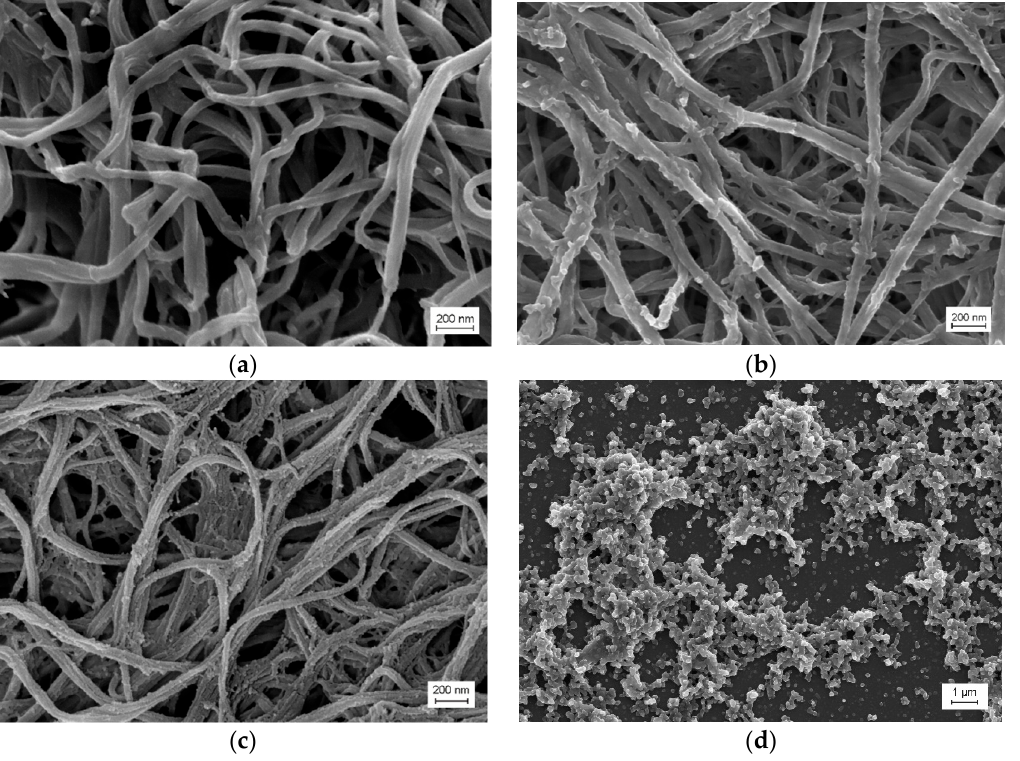
Figure 1. Micrographs of different gel samples obtained using scanning electron microscopy (SEM): Fibrin gel ( a ); composite gel Fibrin/RG ( b ); composite gel Fibrin/DPPC/RG with binase ( c ); pure RG ( d ). DPPC— 1,2-dipalmitoyl-sn-glycero-3-phosphocholine.